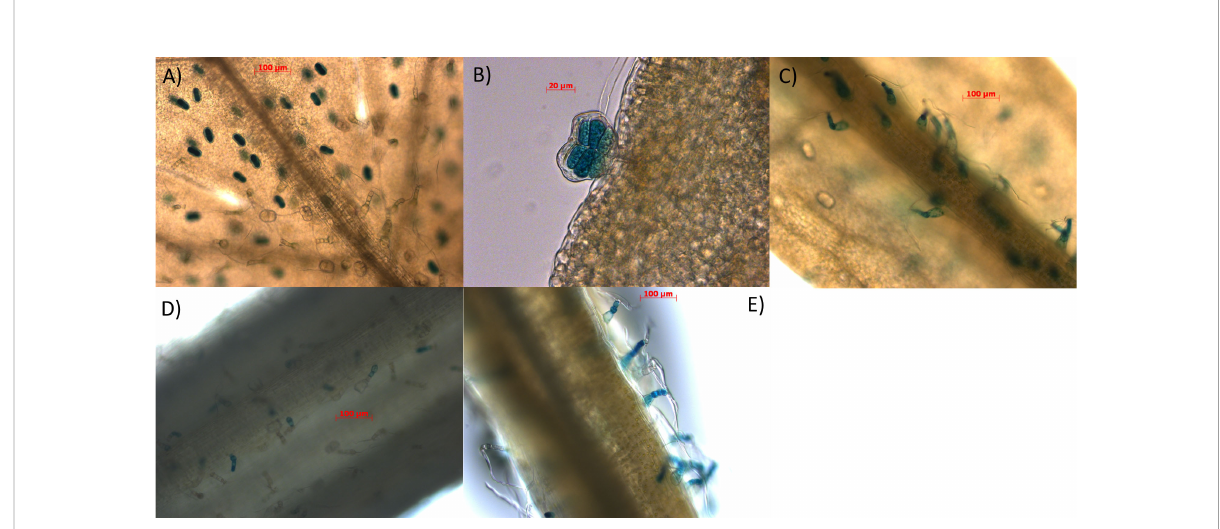
FIGURE 4 Characterisation of AaBPS promoter using promoter-GUS fusions. Tissues of 12-weeks old transgenic lines expressing pAaBPS::GUSi : (A) juvenile leaf (10x) (B) juvenile leaf (40x) (C) mature leaf (10x) (D) leaf petiole (10x) (E) stem (10x) were stained for GUS activity as described in Materials and Methods and photographed using bright- fi eld microscopy (magni fi cation indicated in the brackets). Scale bars indicated for each picture in